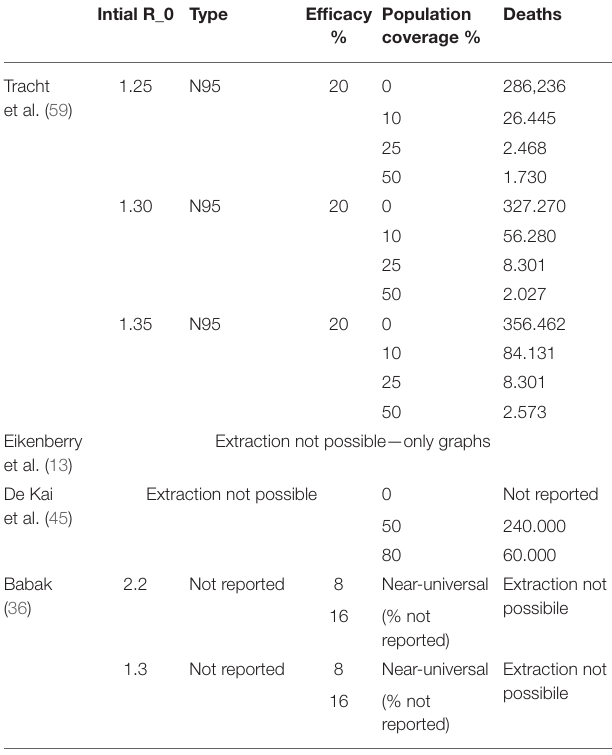
TABLE 2 | Mortality rate in the quantitative-deterministic